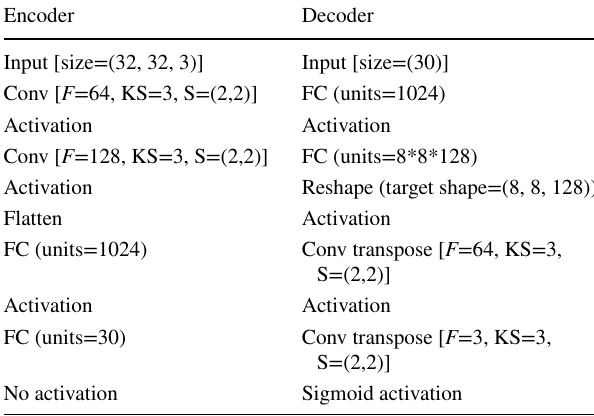
Table 2 Autoencoder architecture for 3-channel image datasets